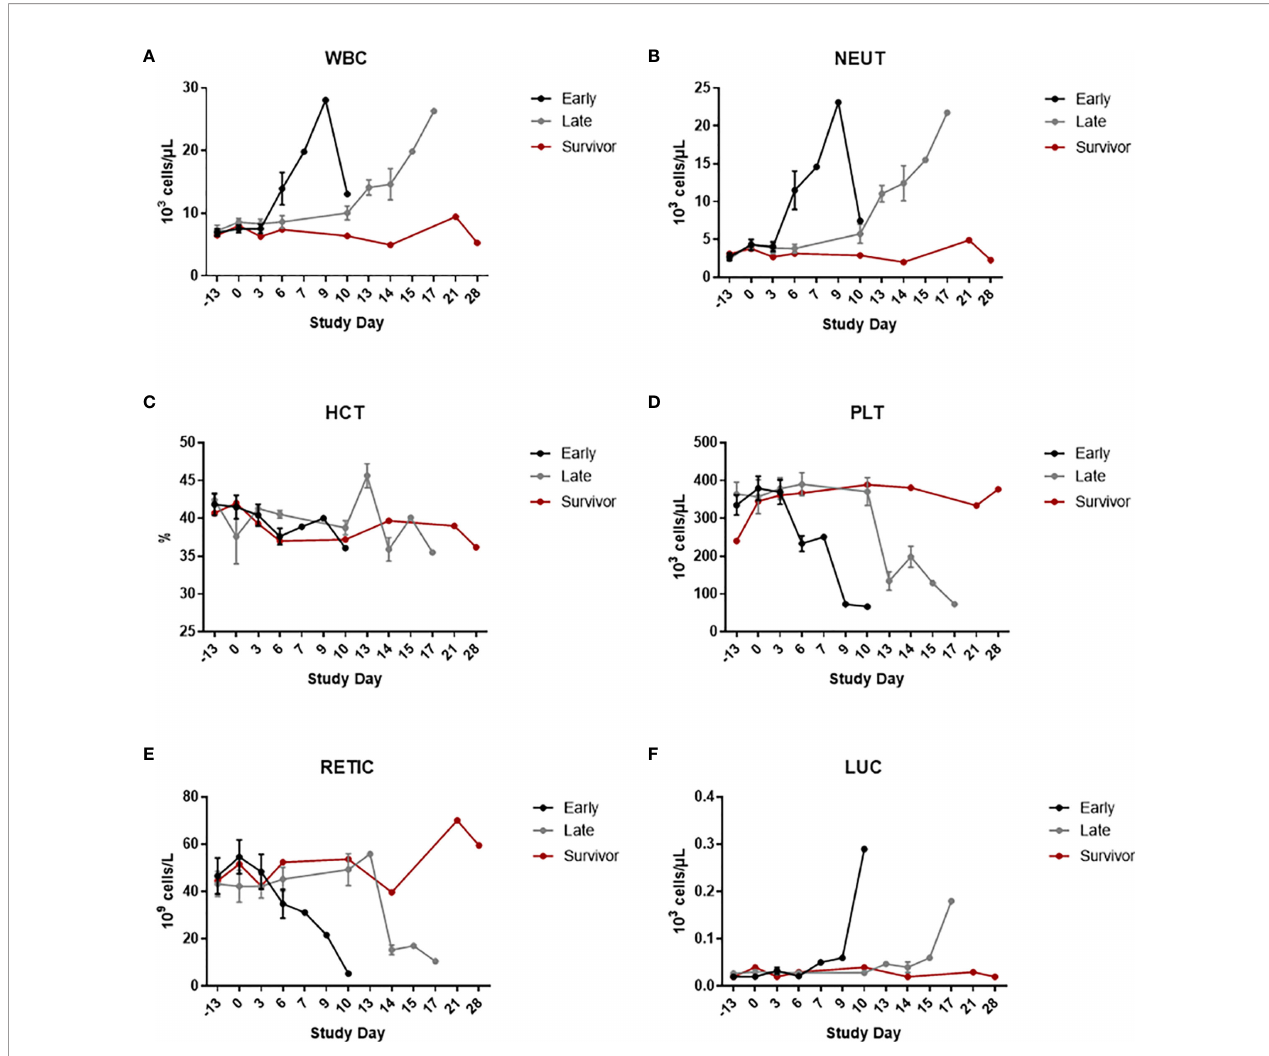
FIGURE 3 | Hematology. Hematology was measured using an ADVIA 120 Hematology System. The graphs in this fi gure show data grouped by survival phase (i.e., early-phase, late-phase, and survivor). (A) WBC; (B) NEUT; (C) HCT; (D) PLT; (E) RETIC; (F) LUC. Error bars represent the